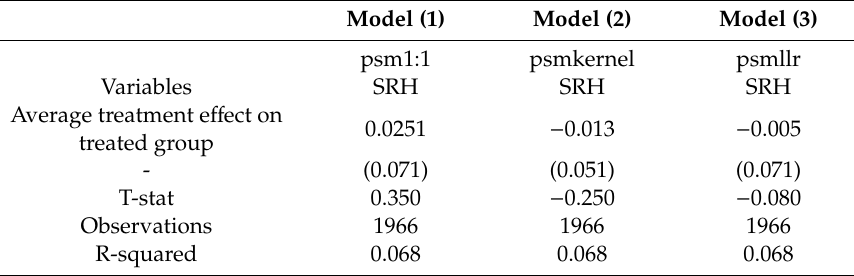
Table 7. The results of the PSM (propensity score matching) model.